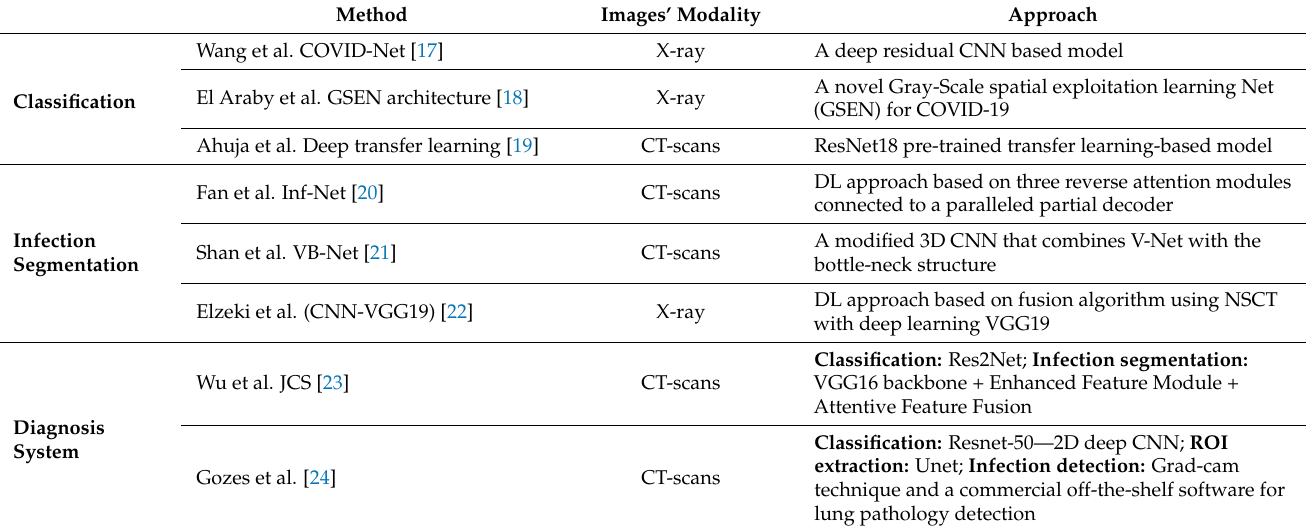
Table 1. A summary of the recently published studies on COVID-19 detection